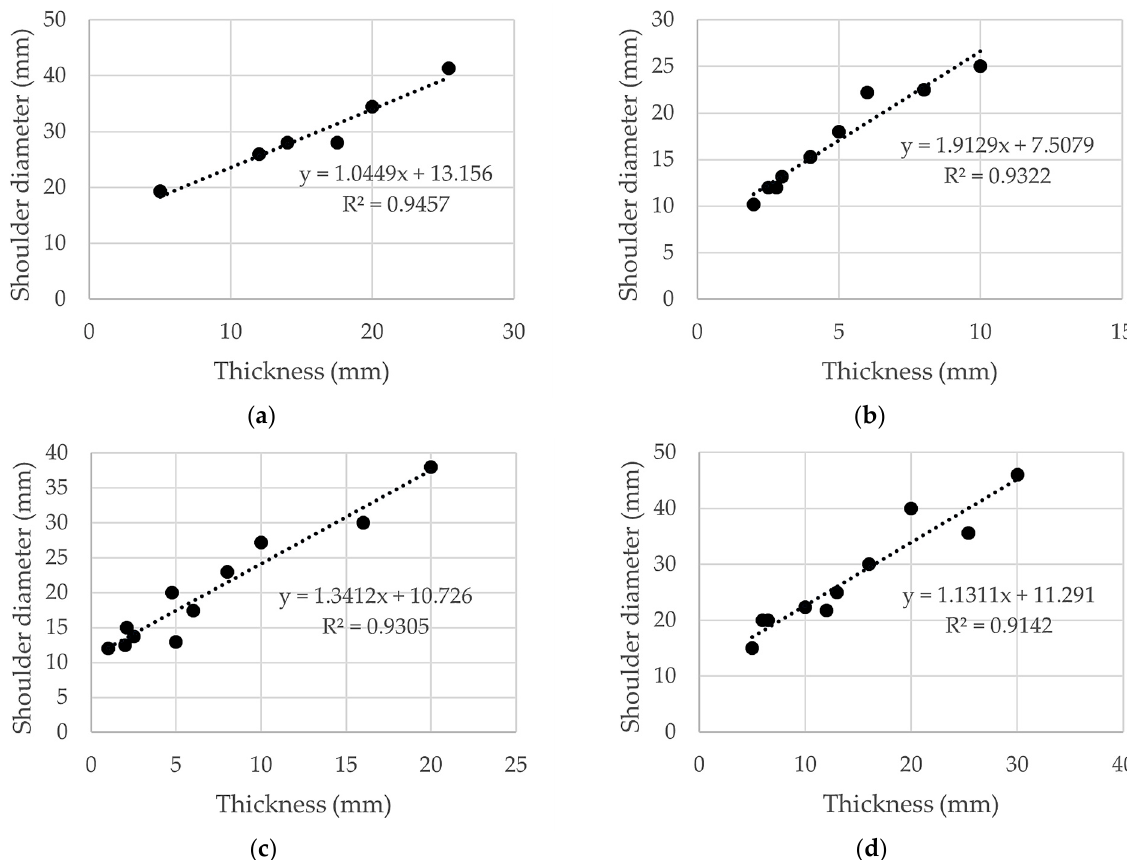
Figure 7. Shoulder diameter vs. thickness for series: ( a ) 2XXX; ( b ) 5XXX; ( c ) 6XXX; and ( d ) 7XXX.